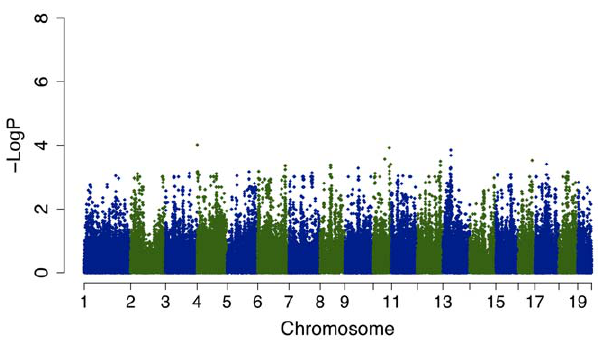
Figure 3. Manhattan plot of mouse AHR slope EMMA results. The x-axis denotes position along each chromosome. The y-axis denotes –Log 10 (P) corresponding to EMMA P-values. None of the P- values are significant after corrections for multiple comparisons, but all those with nominal P-values , 0.001 were selected for further study.